Question: Describe this figure in one sentence.
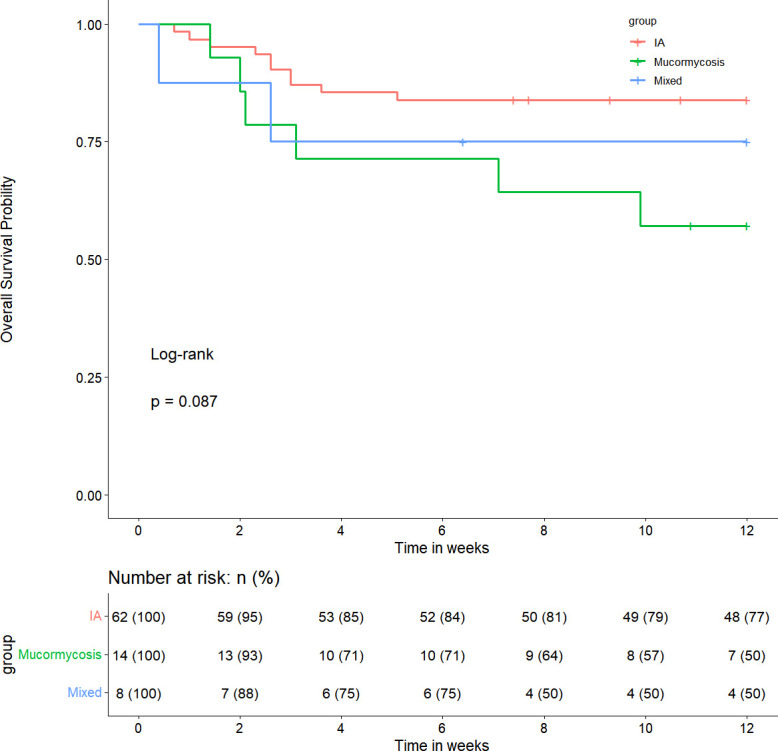
Answer: Kaplan-Meier curves for week 12 all-cause mortality stratified by infection type. Kaplan-Meier estimates of cumulative all-cause mortality are shown for patients with IA ( n = 62), mucormycosis ( n = 14), and mixed infection ( n = 8). The risk table displays the number of patients at risk at weeks 0, 4, 8, and 12. Tick marks indicate censored patients. IA, invasive aspergillosis. Pairwise log-rank P -values are provided in Table S2 .